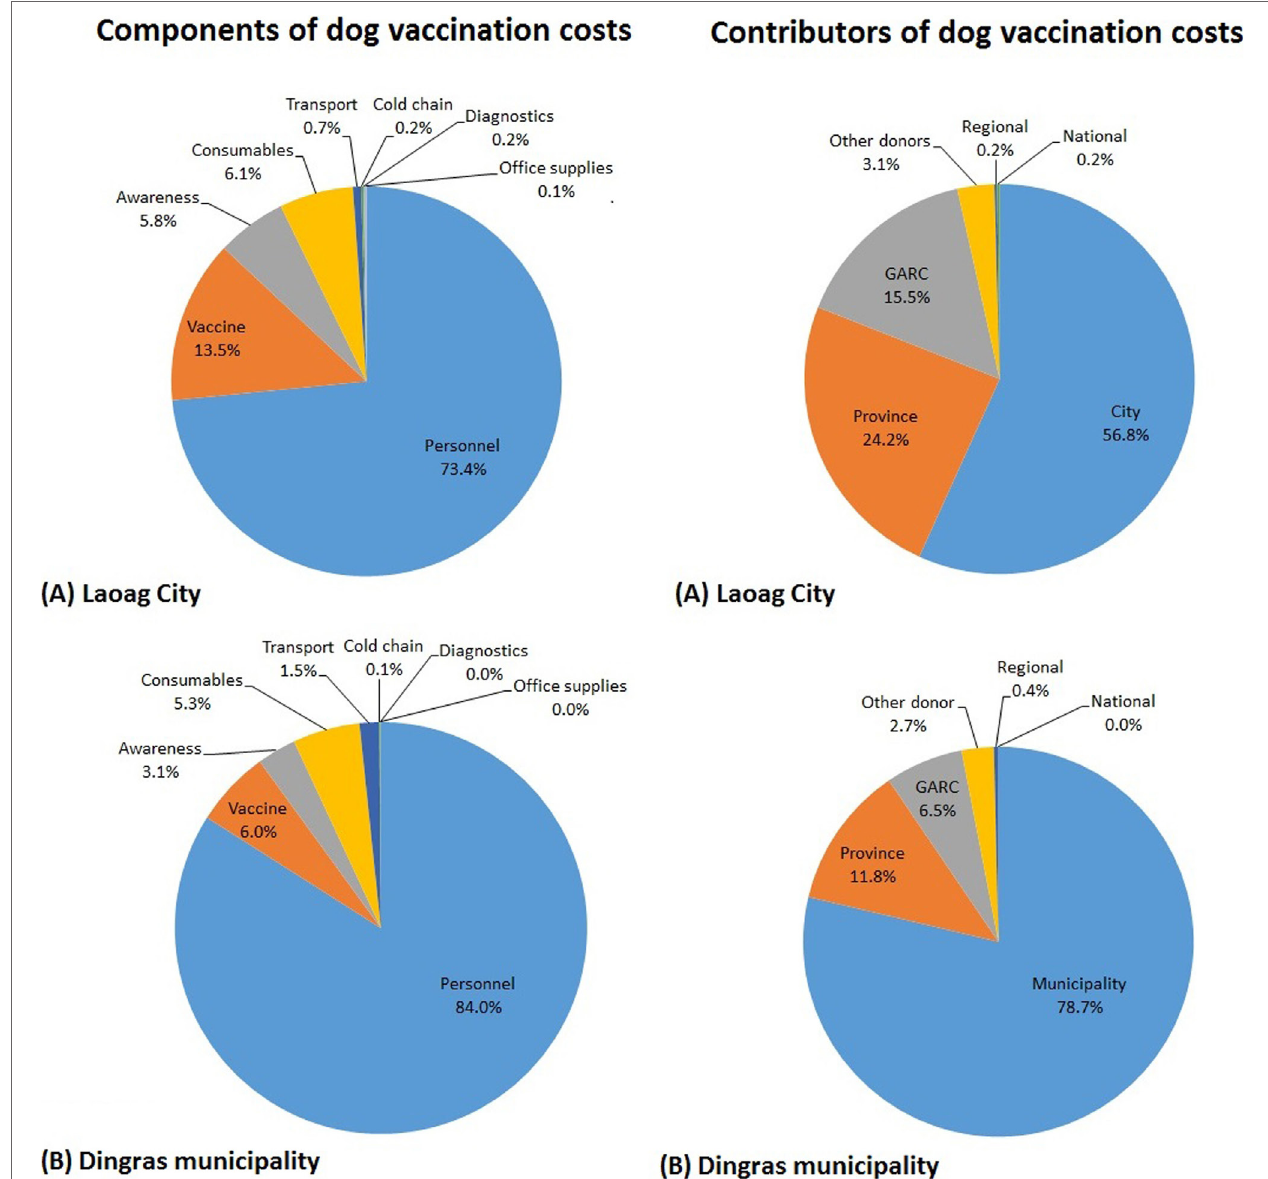
FigUre 1 | The cost of vaccinating dogs divided into the different components and between the different project contributors for (a) laoag city and (B) Dingras Municipality from 2012 to 2014